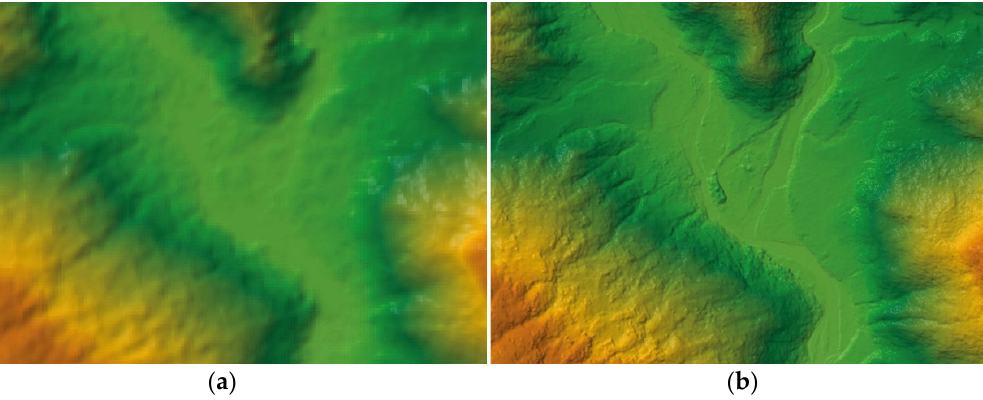
Figure 2. The region around Punakha, represented by the STRM 30-m DEM ( a ) and by the EM3D 5-m DEM ( b ).